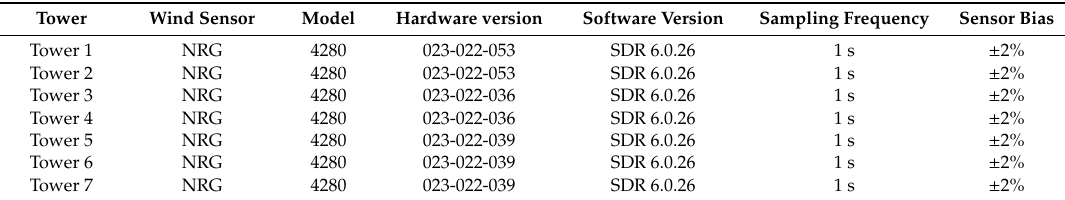
Table 2. Wind towers’ sensor type, model number, hardware version, and software